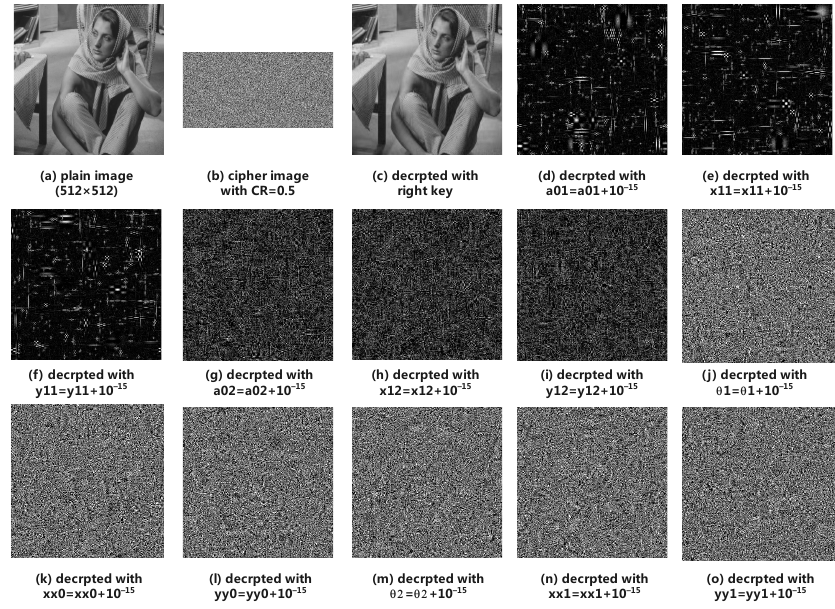
Figure 8. Decryption with tiny modified